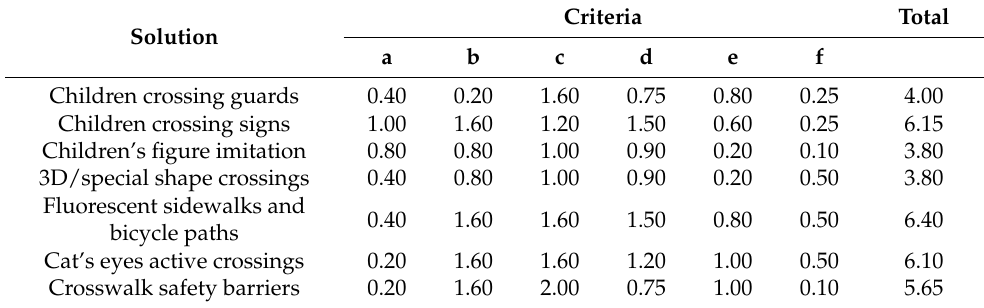
Table 2. Multi-criteria assessment of infrastructural solutions increasing children’s road safety. Solution